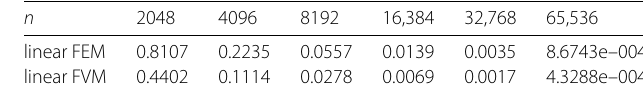
Table 3 The error in the relative discrete L 2 -norm for problem (5.1) with k = 500